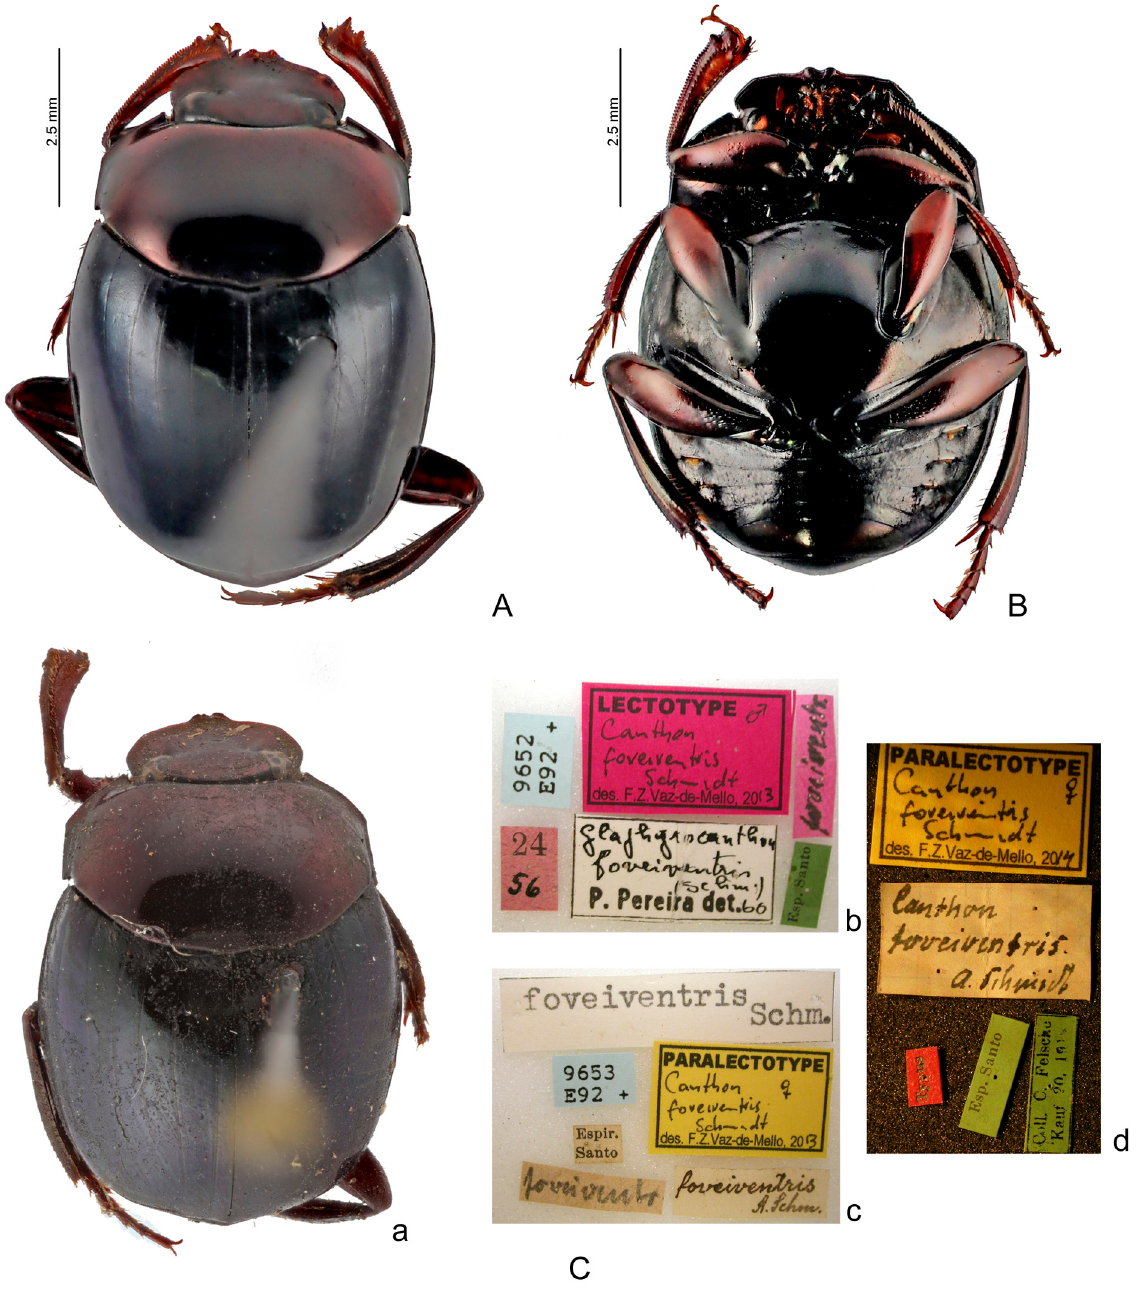
Fig. 23. Sylvicanthon foveiventris (Schmidt, 1920). A . Dorsal view. B . Ventral view. C . S. foveiventris type material: a . Lectotype. b . Lectotype’s labels. c . Paralectotype 1’s label. d . Paralectotype 6’s